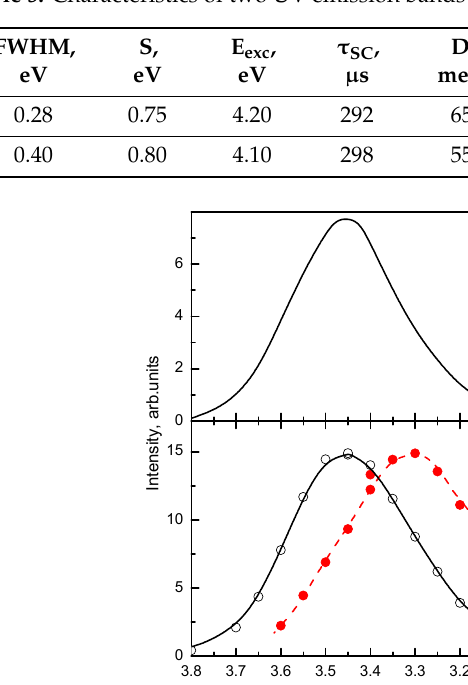
Table 5. Characteristics of two UV emission bands of Lu 2 SiO 5 :2.24 at.% Bi at 4.2 K.